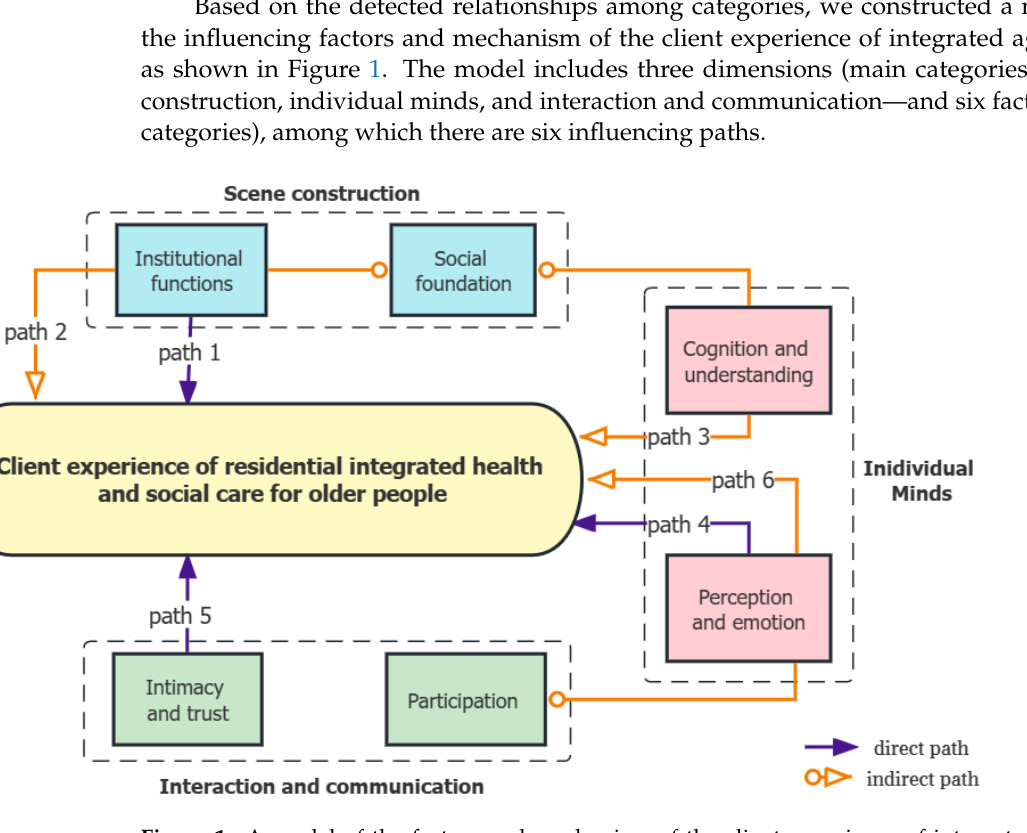
Figure 1. A model of the factors and mechanism of the client experience of integrated care for older people.